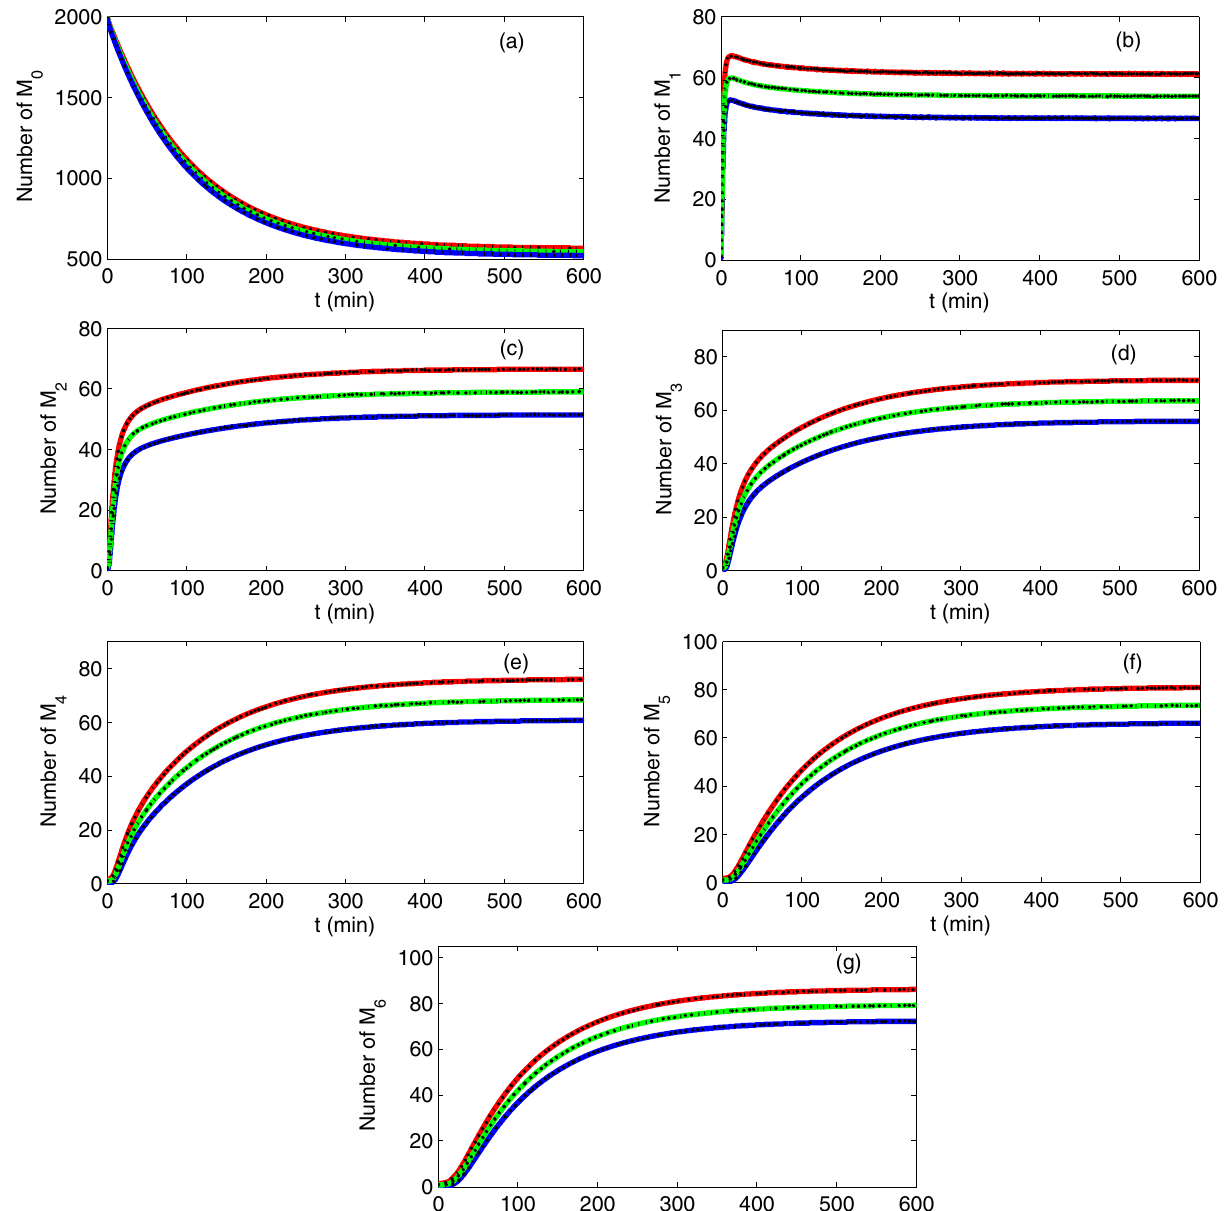
Figure 2. The time evolution of the number of M 0 , M 1 , M 2 , . . . , M 6 . Comparison of the mean + standard deviation (upper red curve), mean (middle green curve) and mean − standard deviation (lower blue curve) by moment closure method (solid curves) and SSA (block dots). The initial condition is x 1 ( 0 ) = 2000 , x 2 ( 0 ) = . . . = x 7 ( 0 ) = 1 and parameter values are k p = 0 , K 0 = 0.01min − 1 , K a = 0.002 min − 1 , K 6 = 0.1min − 1 , K b = 0.1min − 1 . The results by SSA are based on 10,000